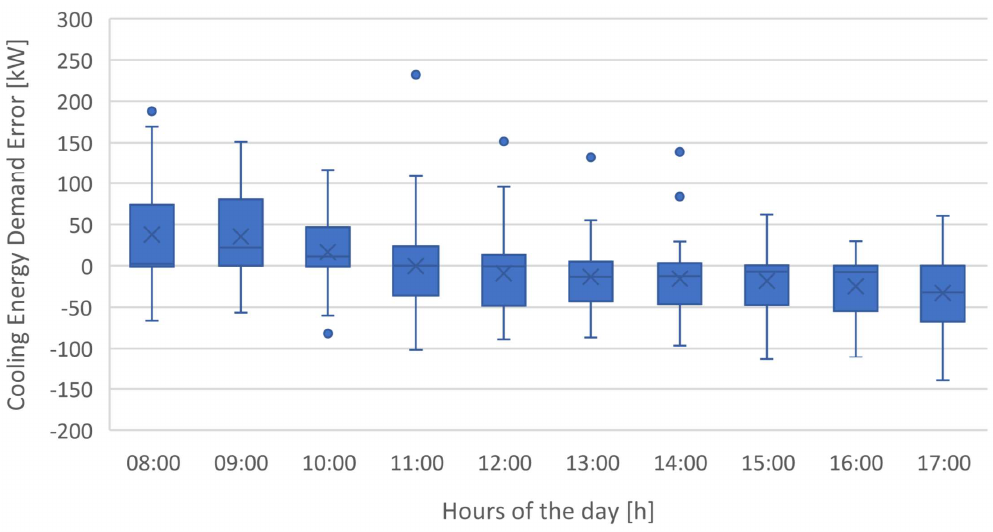
Figure 15. Cooling energy demand error distribution during the test period using SVM.